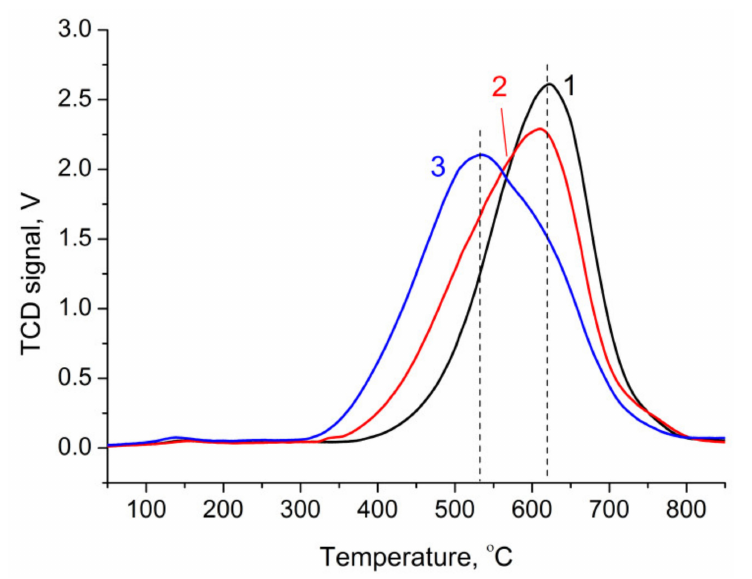
Figure 3. TPR profiles of NiAlO x -2 (line 1), NiAlO x -3 (line 2), and NiAlO x -4 (line 3). Pre-calcination temperature was 600 ◦